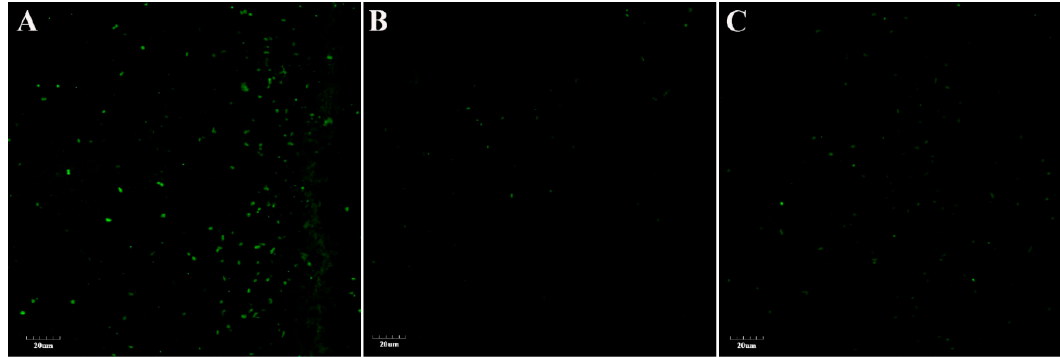
Figure 4. The higher level of green fluorescence indicating the higher level of Reactive Oxygen Species (ROS) in FZB42 strain grown for 96 h at 4 °C ( A ). The lower fluorescence depicts lesser ROS production in the cells of strain CJCL2 ( B ). The level of ROS as shown by fluorescent cells in strain RJGP41 ( C ).